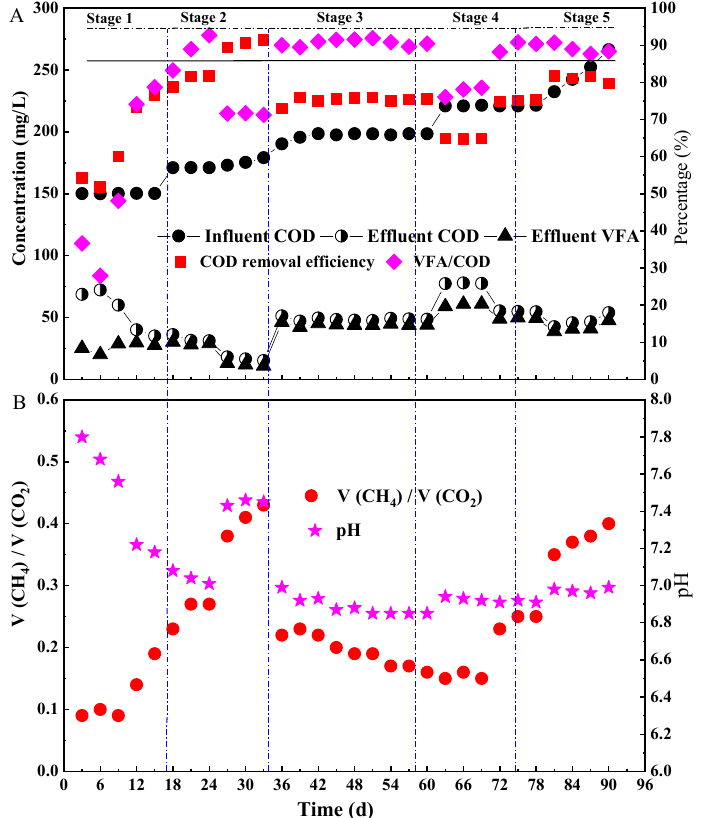
Figure 2. Performance of the ASBR. ( A ) COD removal and VFA production; ( B ) V(CH 4 )/V(CO 2 ) and pH.